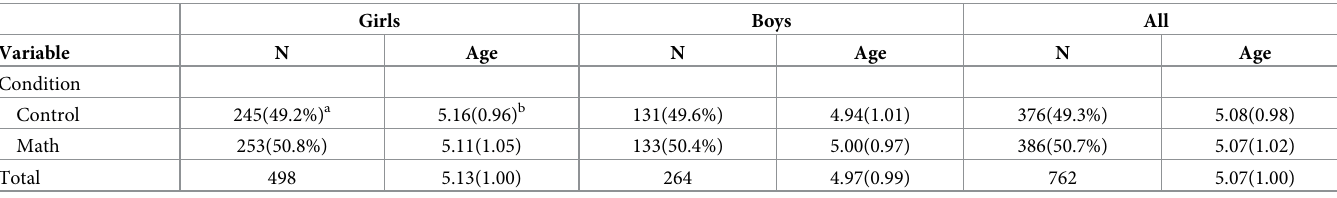
a Values in parentheses indicate percentage of participants of each gender. b Values in parentheses indicate standard